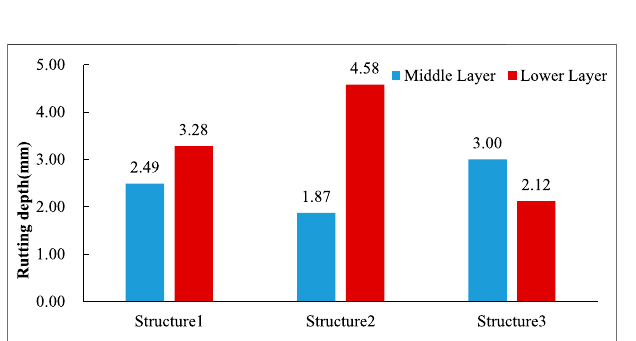
FIGURE 8 | French rutting test results of asphalt mixtures for each pavement structure.